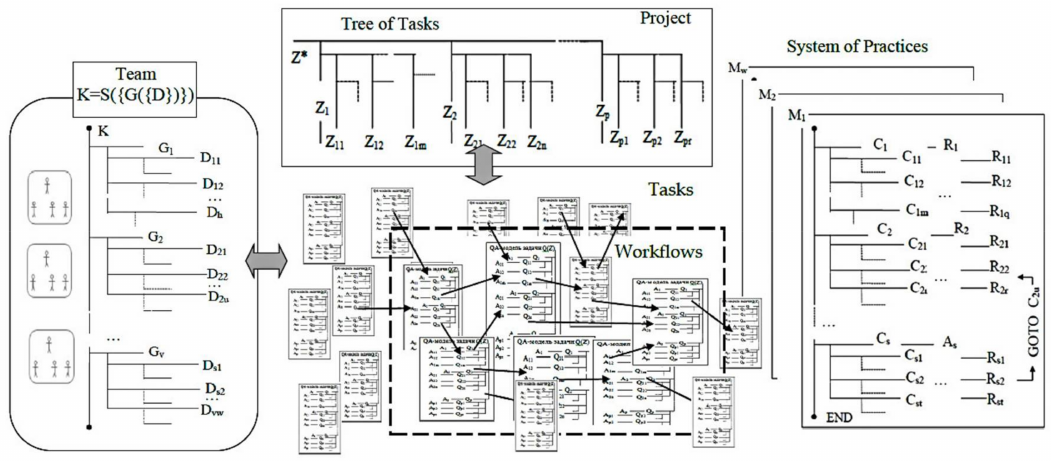
Figure 6. QA-nets of design